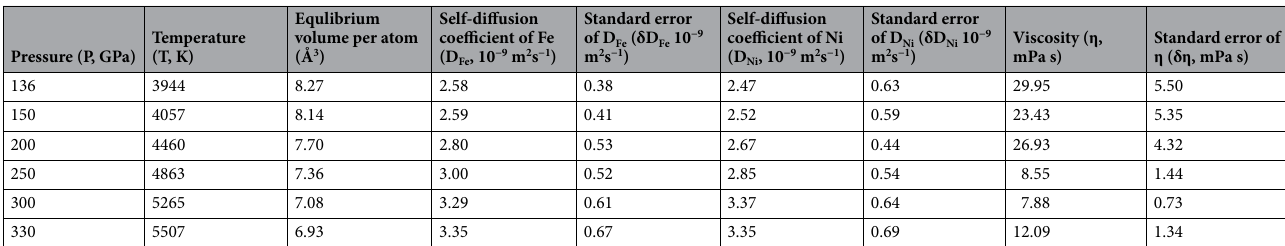
Table 1. Self-diffusion coefficient and viscosity of FeNi fluid along the core adiabatic